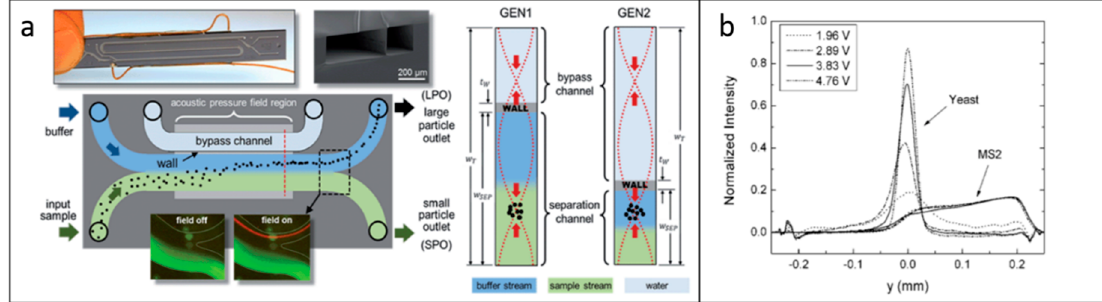
Figure 7. ( a ) Sorting of dengue virus particles and human Raji lymphocytes by acoustic radiation force. Reprinted with permission from reference [108]. ( b ) With increasing voltages, yeast were influenced by increased acoustic radiation force, while MS2 viruses were not influenced. Reprinted with permission from reference [109].